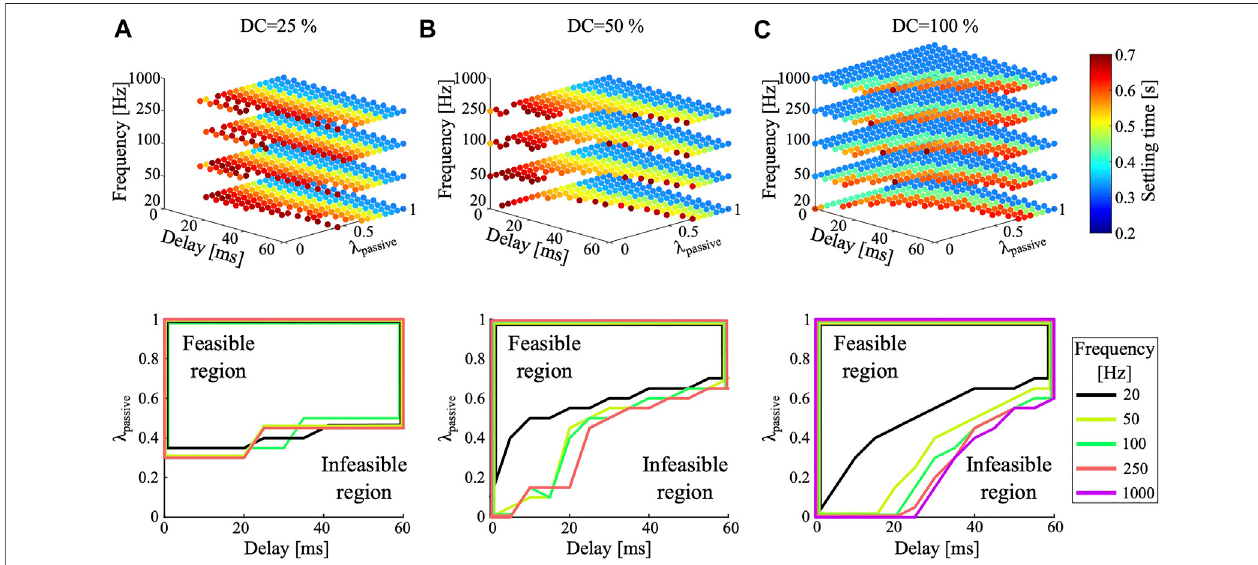
FIGURE 6 | Simulation results: Dropping the hybrid actuated robot leg from a height of 42.5 cm. Parameters varied are duty cycle (DC), control frequency, system delay, and compliance ratio ( λ passive ). The reference landing performance is the top left data point in each plot. It presents the behavior of the fully passive leg ( λ passive (cid:1) 1 . 0). Plots for DC (cid:1) 25% and DC (cid:1) 50% show no data for 1,000 Hz; with a step time of 1 ms partial duty cycles are not possible.